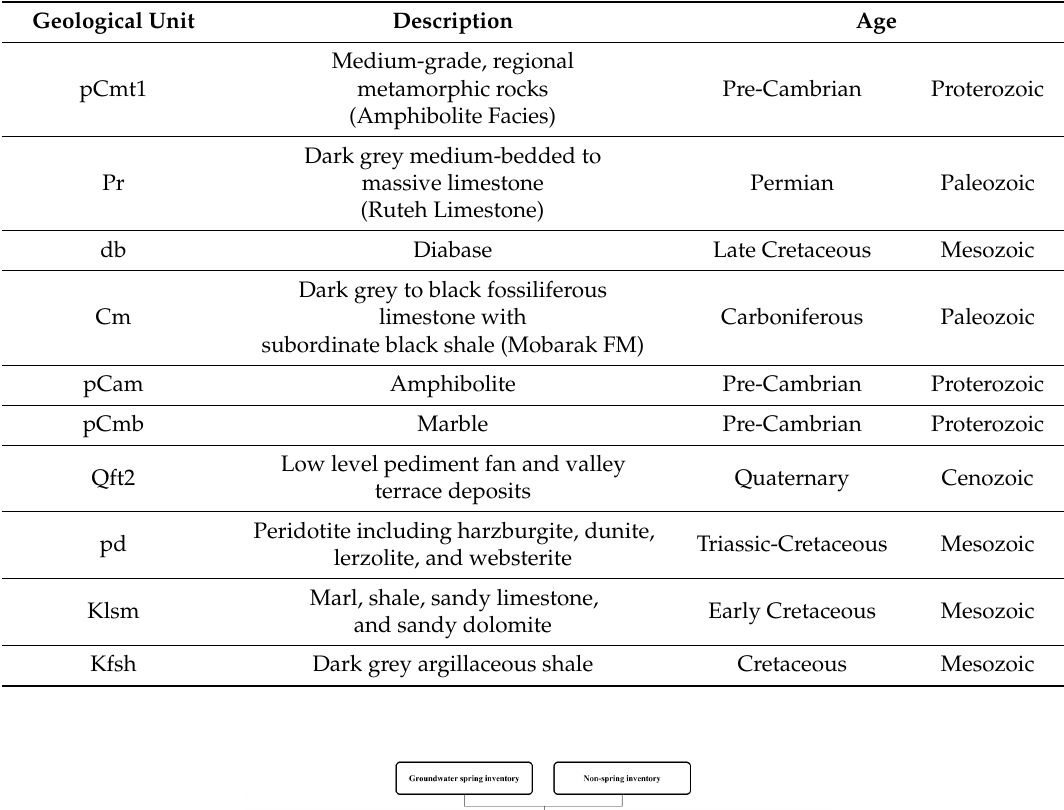
Table 1. Lithology of the study area.